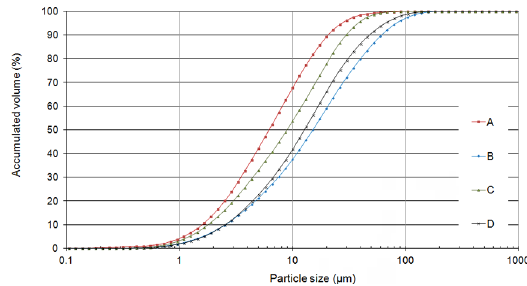
Figure 4. Particle size distribution curves of clays A, B, C, D Table 2. Atterberg limits